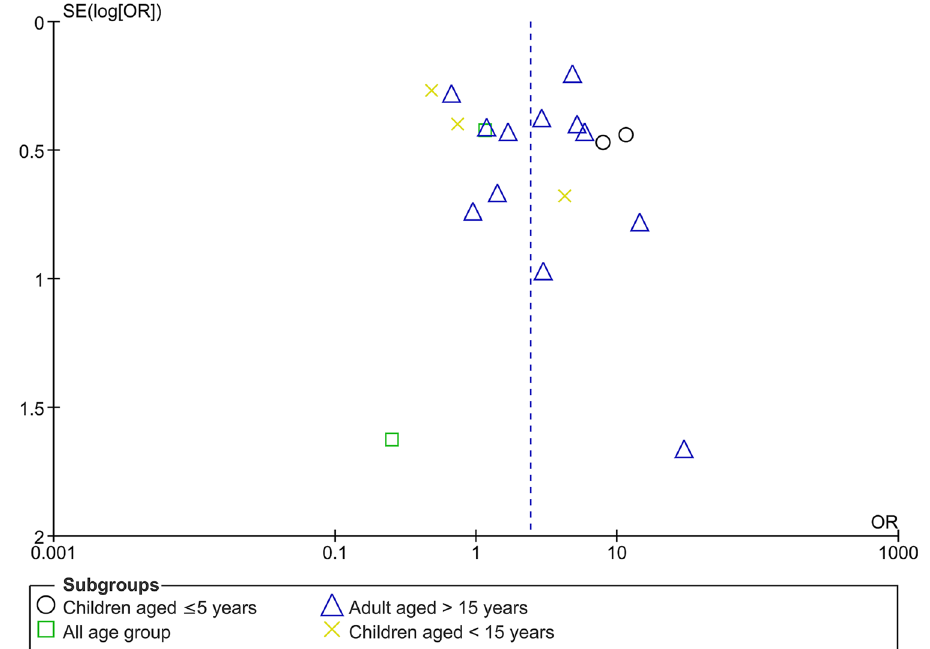
Figure 8. The funnel plot demonstrating publication bias across the included studies.